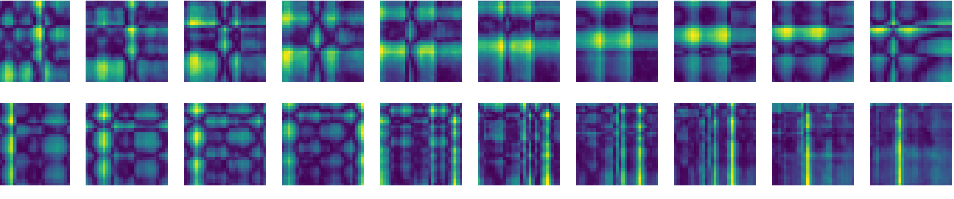
( a ) Some samples predicted by the FNO model.